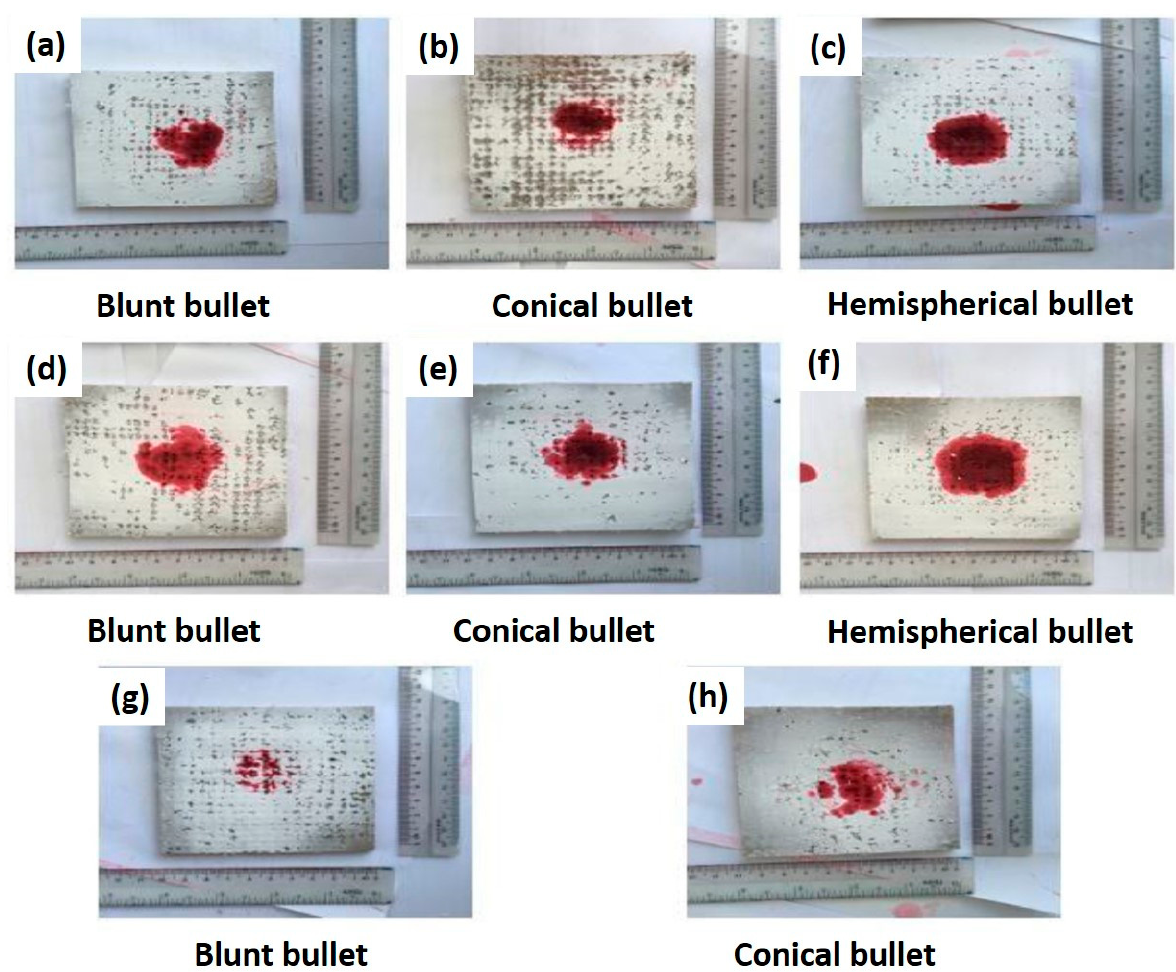
Figure 13. Dye penetrant test shows damage area of; ( a – c ) 30 bar pressure setting; ( d – f ) 40 bar pressure setting; and ( g , h ) 50 bar pressure setting. (Adapted with copyright permission from Azmi et al. [130]).